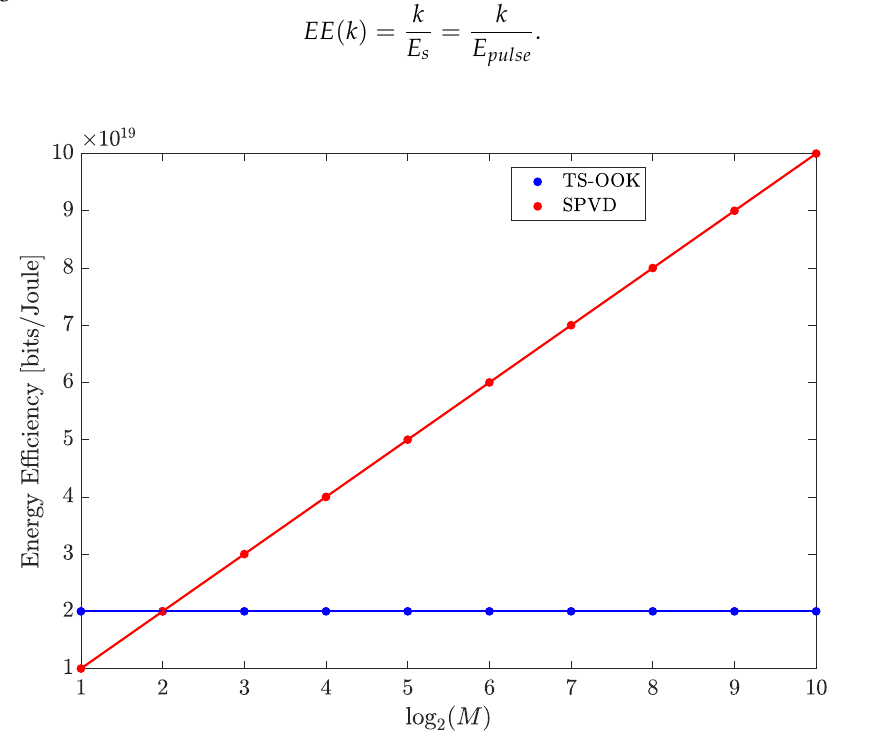
Figure 6. Comparison of Energy